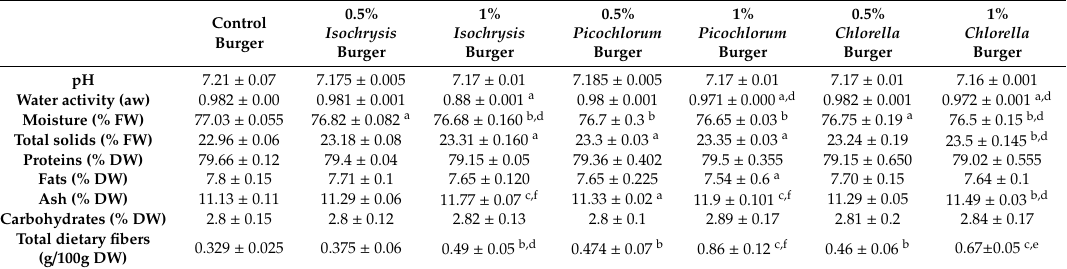
Table 2. Mean values for physicochemical characteristics of control and microalgae-fortified burgers at one week after